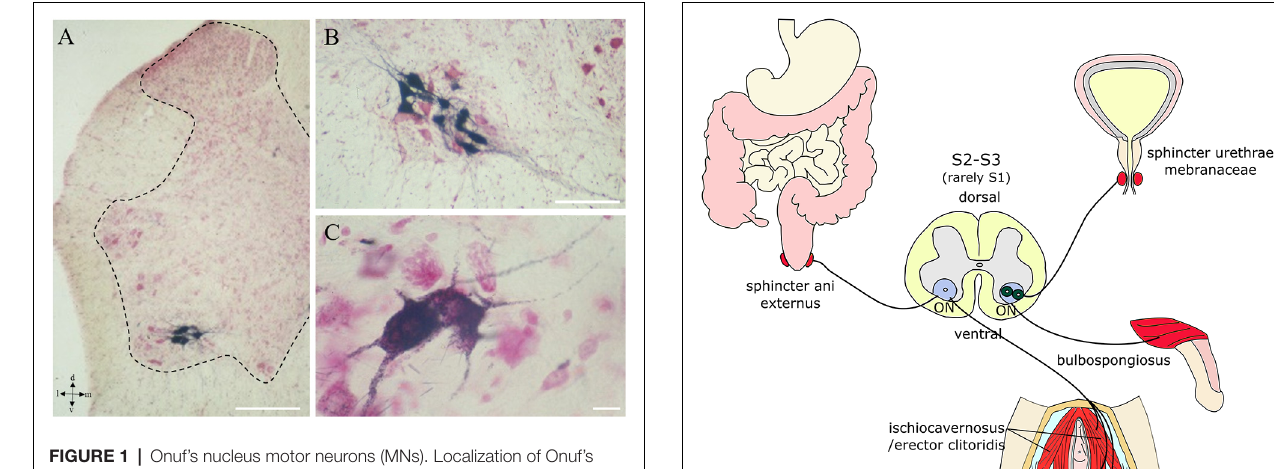
coeruleus, the serotoninergic neurons of the medullary raphe nucleus and the A5 noradrenergic cell group proximal to the superior olivary complex in the pontine tegmentum; Fowler et al., 2008; de Groat, 2017), whereas others specifically regulate